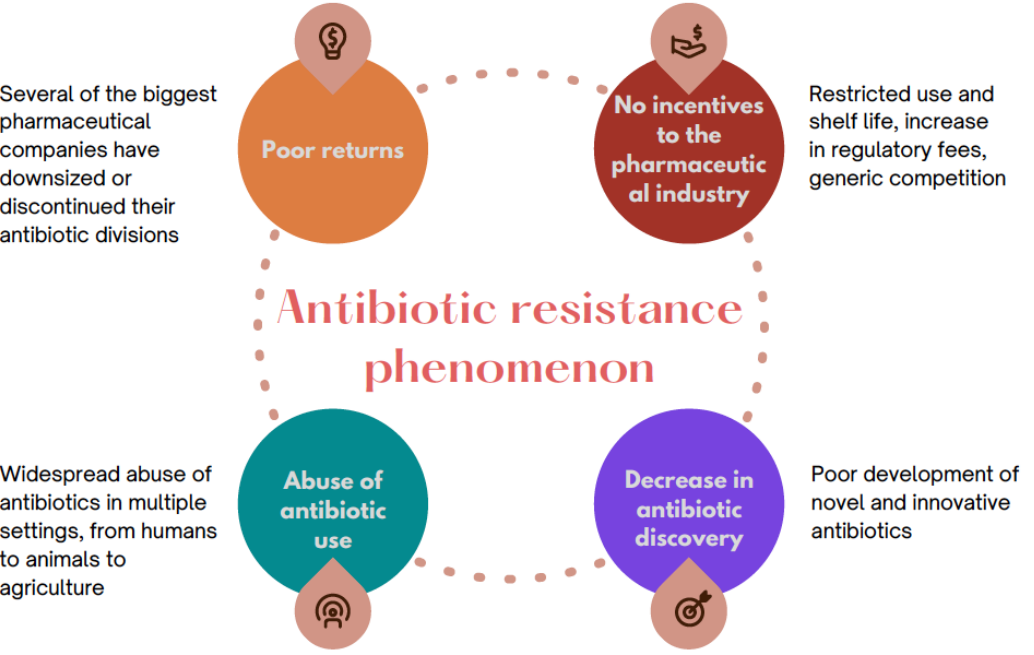
Figure 1. Conceptual illustration of the multivariate issues involved in the phenomenon of antibiotic resistance. otic